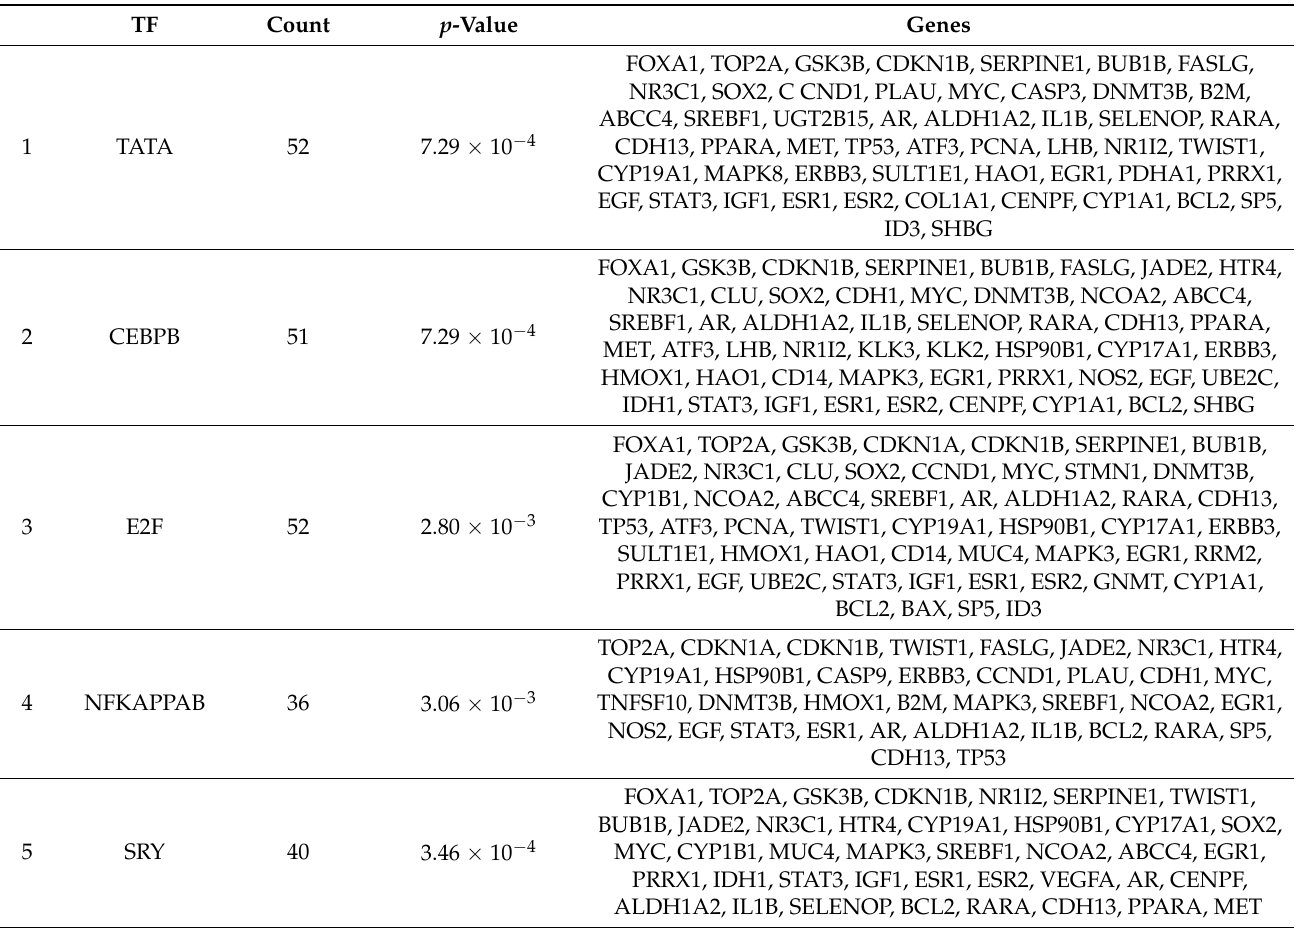
Table 7. Transcription factor binding sites enrichment analysis of the EP and PB influenced 81 over- lapping genes in PCa (UCSC-TFBS: University of California Santa Cruz (UCSC) Genome Browser— Transcription factor binding sites). The highly significant-top five TF with the number of their target genes is shown in this